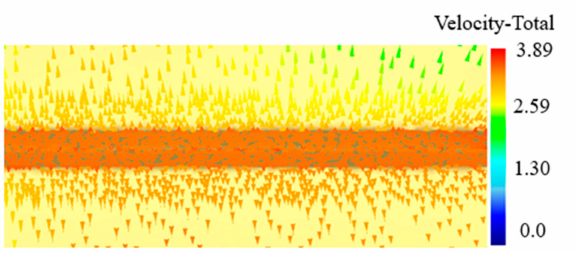
Figure 5. Flow vector of the metal during the stamping process.